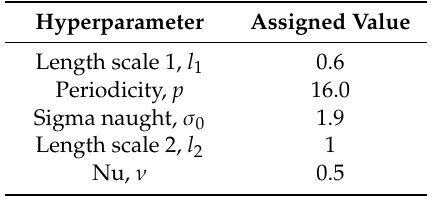
Table 4. Hyperparameters for Gaussian processes